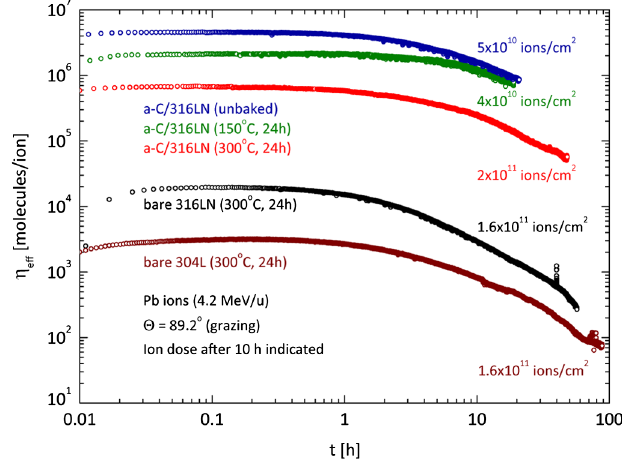
FIG. 3. Comparison of heavy-ion induced desorption yield measurements of amorphous carbon (a-C) films and bare stain- less steel (316LN, 304L) surfaces continuously bombarded under (cid:1) ¼ 89 : 2 (cid:3) with 4 : 2 MeV = u lead ions.